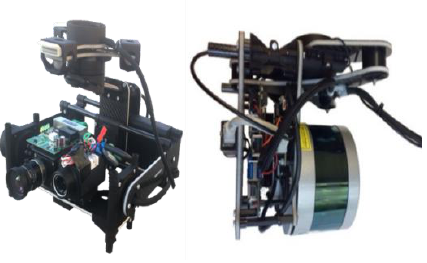
Figure 4: Combined RGB-IR-Payload (left) and LiDAR- payload (right)